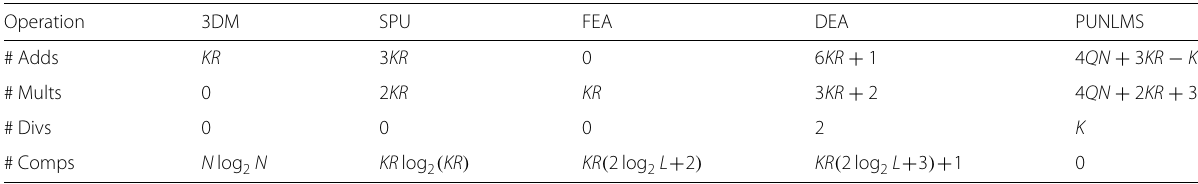
Table 1 Computational effort